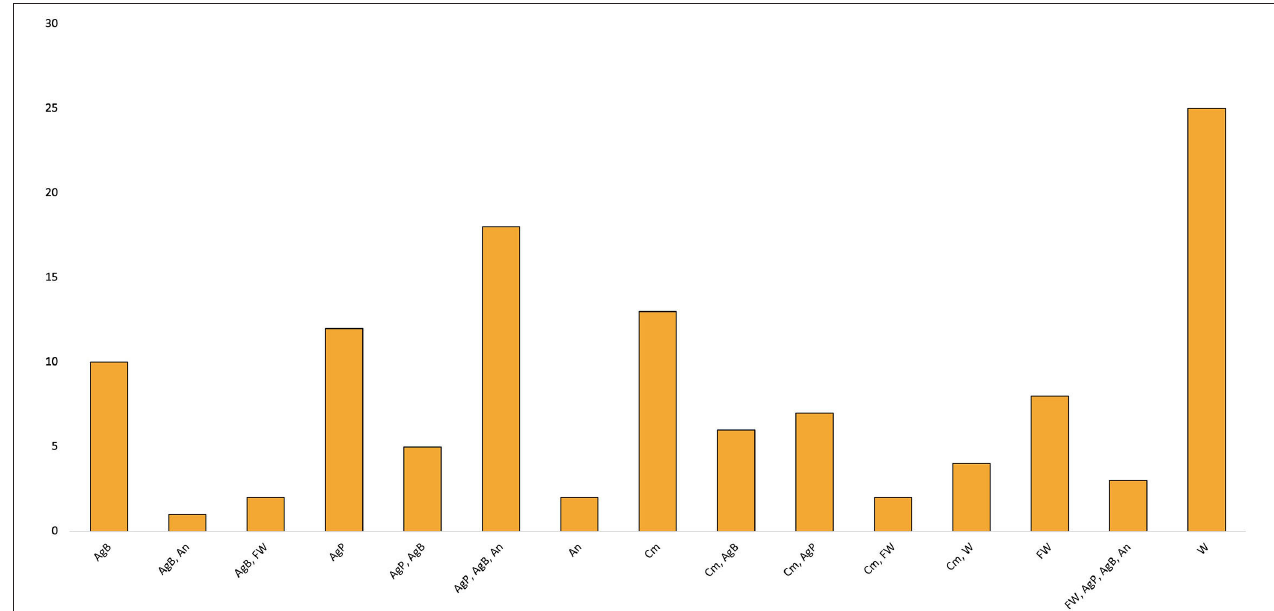
FIGURE 3 | Frequency of feed sources across all diets. AgB, agricultural byproduct; AgP, agricultural product; An, animal byproduct; Cm, commercial feed; FW, food waste; W,